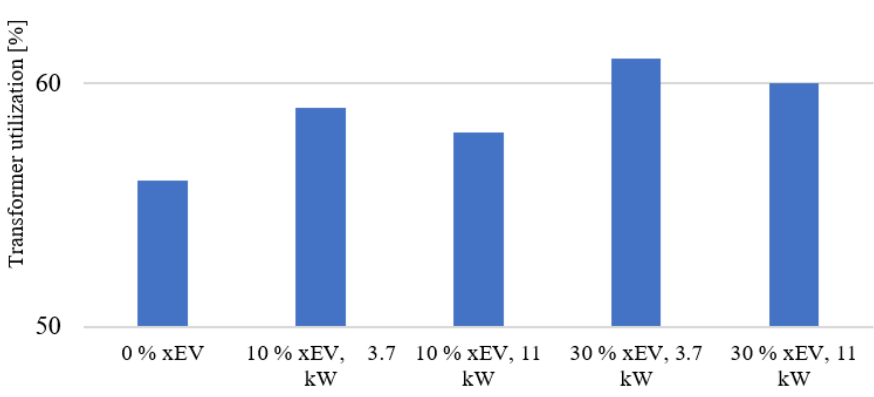
Figure 5. Transformer utilization for the different